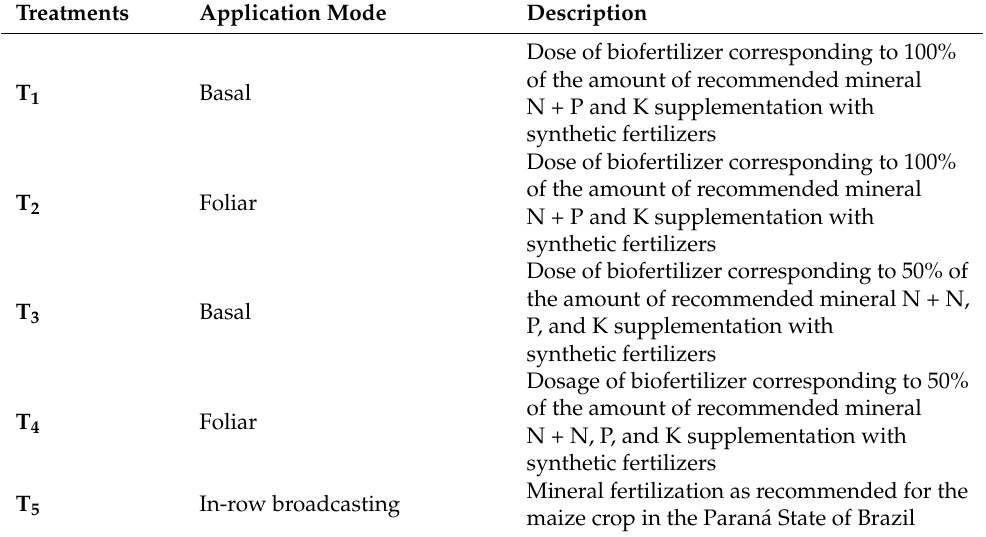
Dose of biofertilizer corresponding to 100% of the amount of recommended mineral